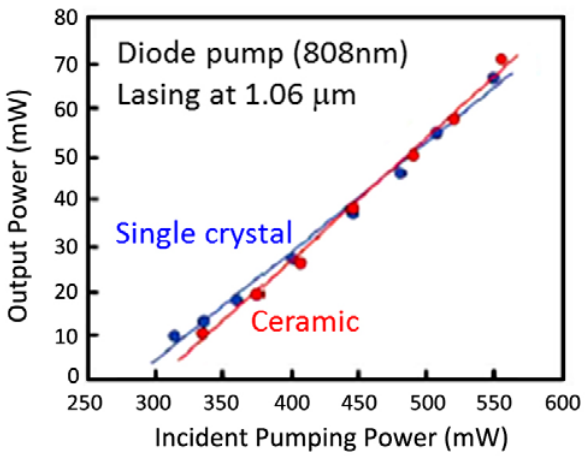
Figure 7. Results of the first Nd:YAG ceramic laser (Adapted from [20]).